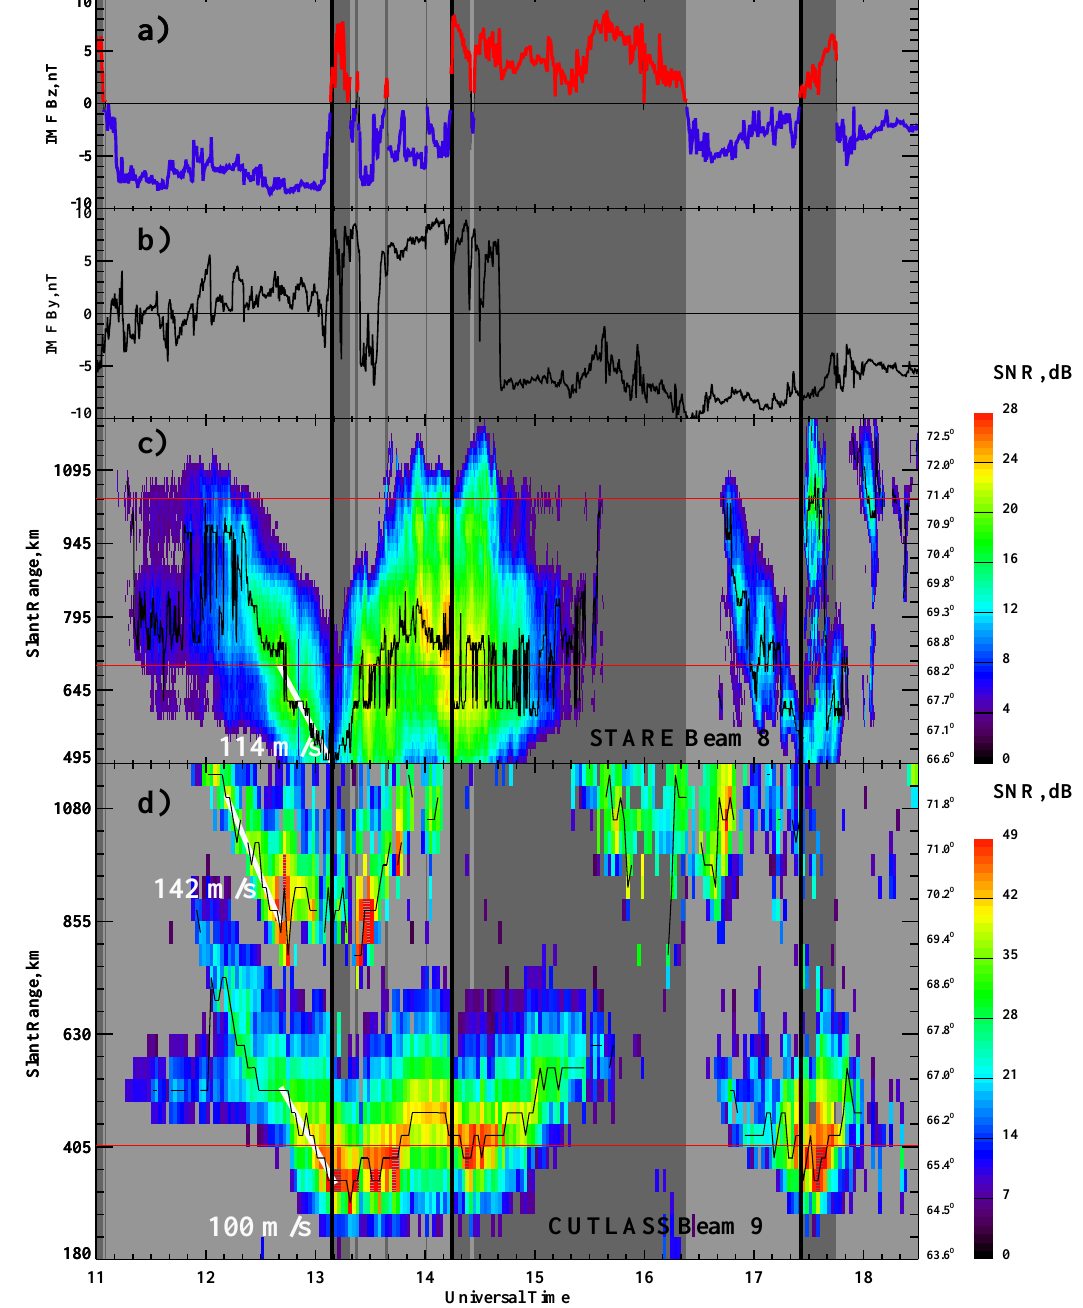
Fig. 3. The panel (a) (and b ) presents the ACE IMF B z ( B y ) data on 14 February 2000, 11:00–18:30UT, shifted by 45min. The positive (negative) B z data are shown by the red (blue) color and the corresponding time intervals are marked by the dark (light) grey shade of the background. Heavy vertical lines show the IMF B z reversals from southward to northward. The range-time-intensity (RTI) plots of the SNR measured at STARE beam 8 and CUTLASS beam 9 (see Fig. 1) are presented in panels (c) and (d) , respectively. The color bars are shown to the right of each RTI plot. Also shown on the right axes of panels (c) and (d) are the geographic latitudes along each radar beam. The red lines in panels (c) and (d) indicate the ranges with the perfect aspect angle at 144 and 12MHz, respectively. The thin ragged lines represent time variation of the range location of the power maximum for each radar. The 12-MHz power maxima have been identified separately for the closer ( r< 800km) and farther ( r> 800km) ranges of the CUTLASS radar measurements. Examples of the linear best fit to the power maxima range variation curves (for the intervals of steady equatorward progress) are shown by the white lines with the apparent echo band velocity along the radar beam indicated by the